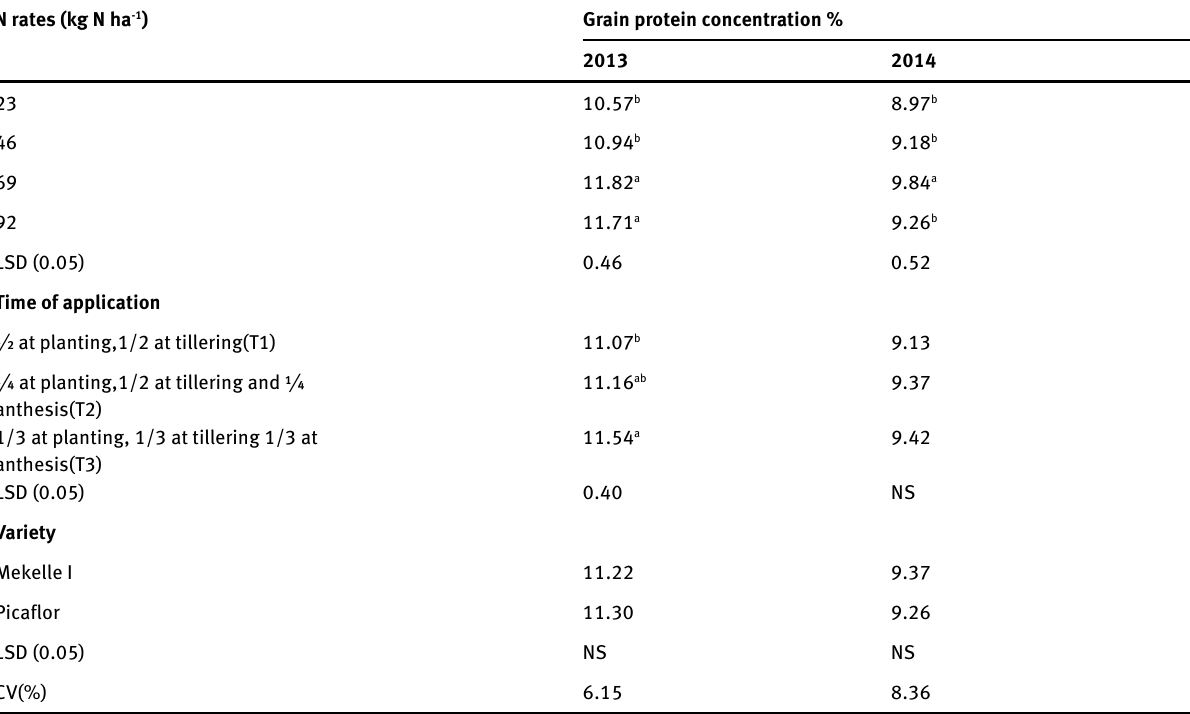
Table 4: Effect of N rate, timing and variety on grain protein concentration of wheat in Enderta district, Tigray in 2013 and 2014 N rates (kg N ha -1